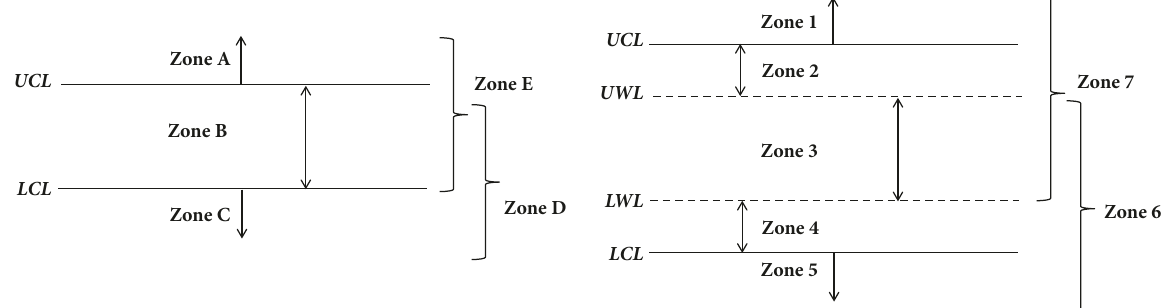
Figure 1: Charting zones of the one-sided and two-sided standard runs-rules (SRR) (i.e., left panel) and improved runs-rules (IRR) (i.e., on the right panel) monitoring